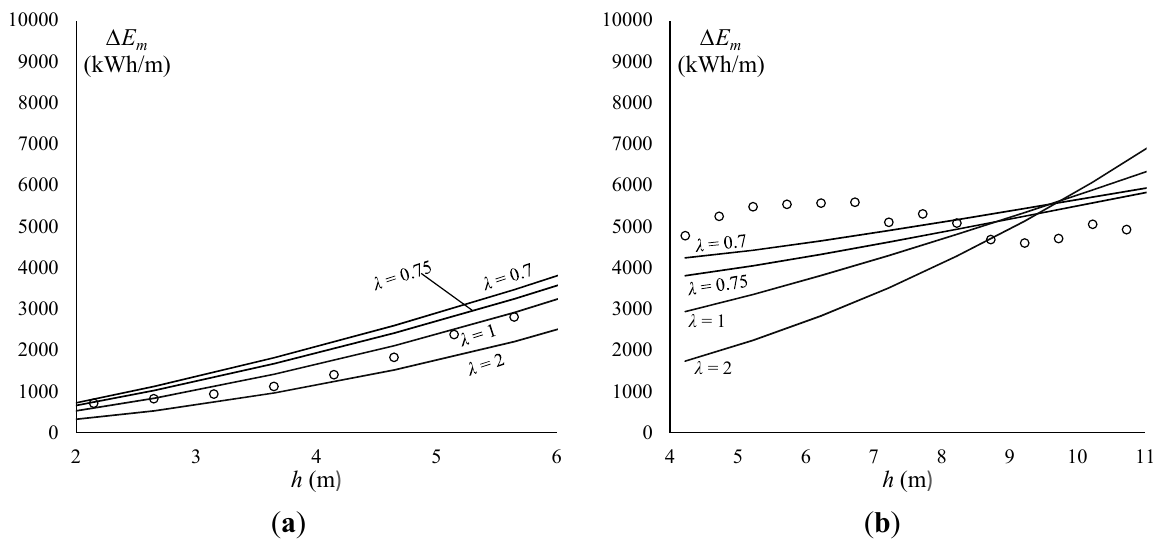
Figure 9. Comparison between average missed energy Δ E m above the threshold h in actual sea (circles) and in EPSs (continuous lines) having various storm shapes λ : ( a ) the buoy 42001; and ( b ) the buoy